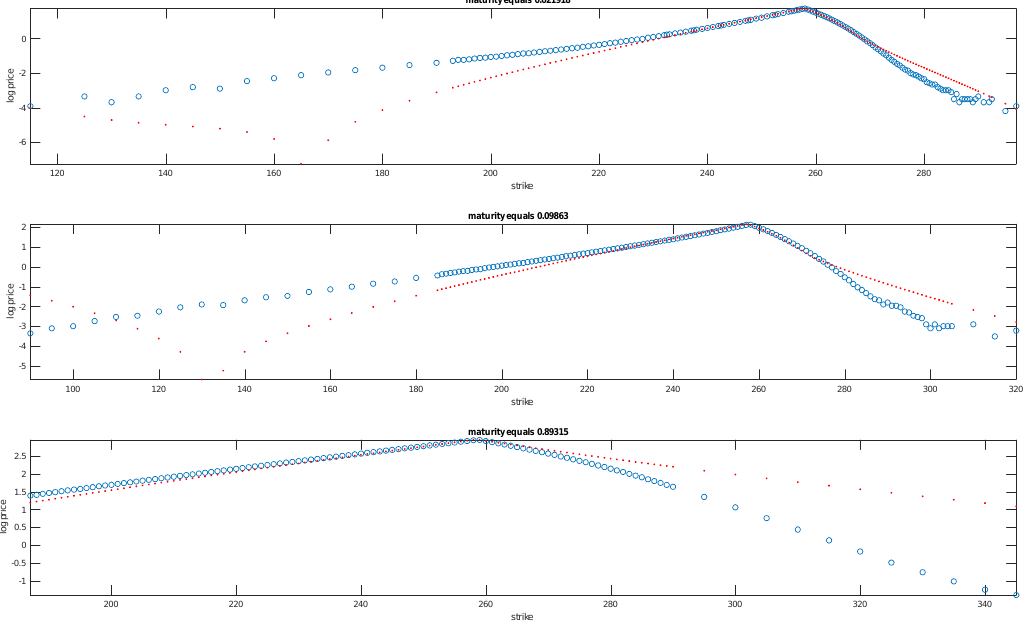
Figure 3: Fit of bilateral gamma to SPY options separately at a number of maturities. Circles show quoted log out of the money option prices, while dots re(cid:135)ect model log prices.